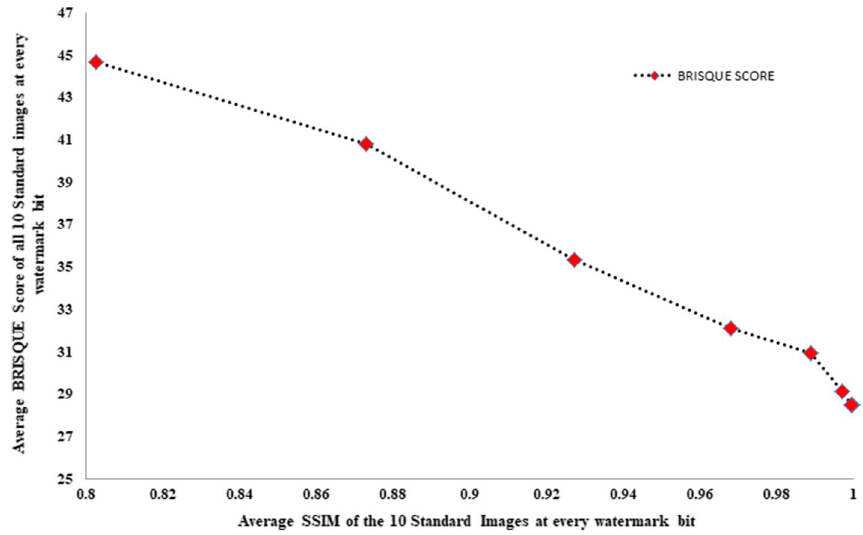
Fig. 5 Average SSIM vs. average BRISQUE